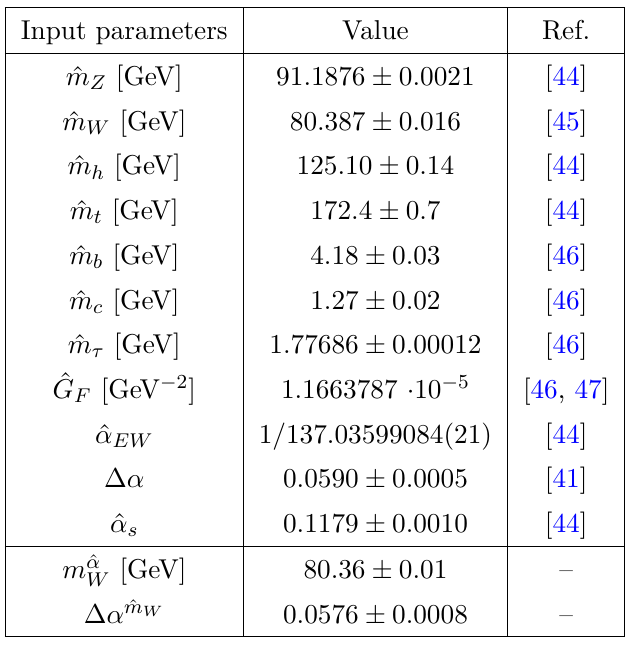
Table 2 . Input parameter values used to predict EWPD theory predictions for both schemes. m ˆ α is the value of m W inferred in the { ˆ α, ˆ m Z , ˆ G F } scheme using the interpolation formula of W refs. [40–43], which includes SM loop corrections, while ∆ α ˆ m W is the shift in the value of alpha due to hadronic effects for the { ˆ m W , ˆ m Z , ˆ G F } scheme. For an introductory discussion on the use of ∆ α relating low scale measurements of ˆ α and higher scale values above the hadronic resonance region see ref. [48]. Note that we use a tree level value of m W , not m ˆ α coefficients for the shifts due to the SMEFT in